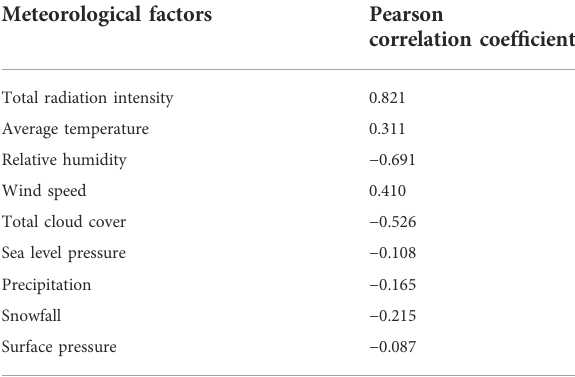
TABLE 2 The Pearson correlation coef fi cient of each meteorological factor.